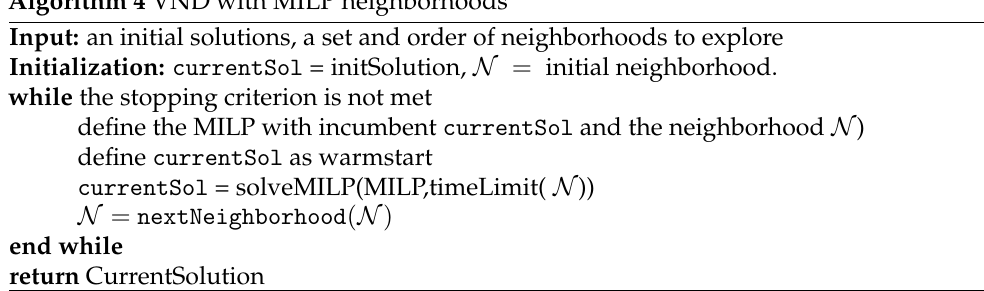
Algorithm 4 VND with MILP